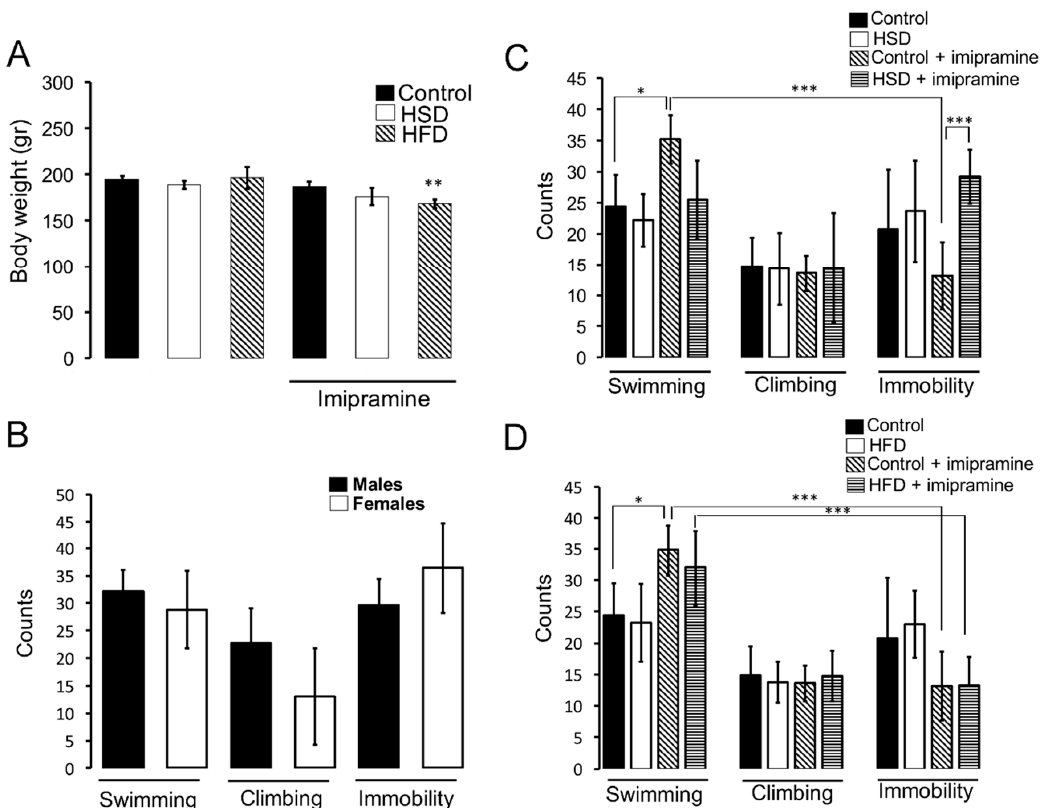
Figure 3. Depressive-like behaviour in HSD and HFD groups. ( A ) Body weight of offspring after i.p. imipramine (30 mg/kg) administration 40 min prior to test session. ( B ) Forced swim test was used